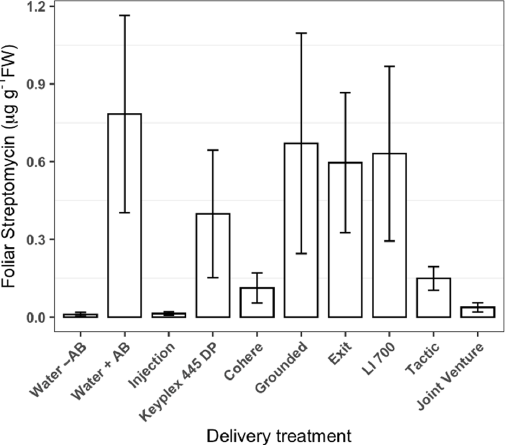
Figure 1. Concentrations of systemically delivered streptomycin in leaves of ‘Hamlin’ sweet orange ( C. × sinensis ) two days after delivery by the foliar application using various adjuvants or trunk injection. Values are concentrations in leaves that were covered to protect them from foliar sprays. The application dose was 0.78 g streptomycin per tree, which is equivalent to the labeled rate for foliar application. Bars represent means and error bars represent standard error ( n = 12). The absence of labeling of treatments with different letters indicates that none are significantly different using Bonferroni’s protected least significant differences ( p < 0.05). AB: anti-bacterial compound, in this case streptomycin. Bars not labeled with letters indicate that the treatment effect was not significant according to an analysis of variance. Table 1. Concentrations of streptomycin and oxytetracycline in covered or directly sprayed leaves of ‘Hamlin’ sweet orange ( C. × sinensis ) after foliar application in two different adjuvant studies. Table 2. Cycle threshold values for detection of ‘ Candidatus Liberibacter asiaticus’ DNA in leaves of ‘Hamlin’ sweet orange ( C. × sinensis ) before and after foliar application or trunk injection of two different adjuvant studies. P (T) represents a two-tailed paired t -test. Post-treatment sampling was 1 month after